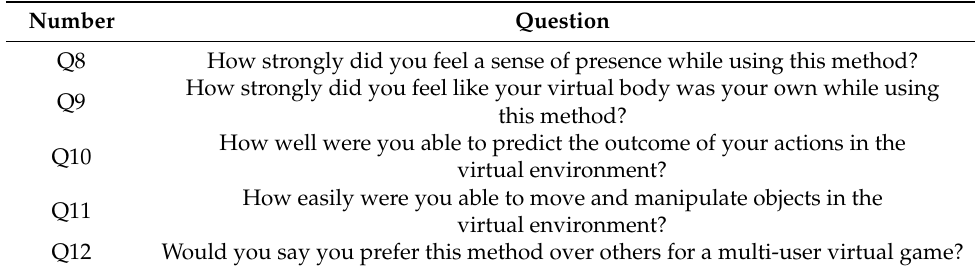
Table 7. Questionnaire for the archery game. Table 8. Questionnaire for the ball-grabbing